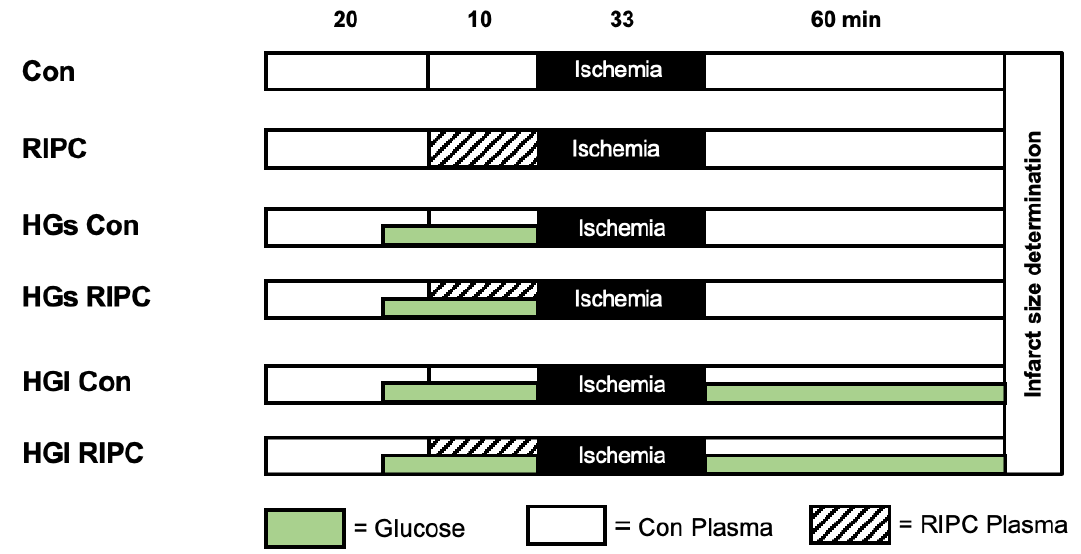
Figure 3. Experimental protocol (Part 2). Con = control plasma; RIPC = RIPC plasma; HG = hyperglycemia; HGs = hyperglycemia short; HGl = hyperglycemia long; Green bar = hearts were perfused with a total of 22 mmol/L glucose concentration. Control ( Con ) : hearts were perfused with control plasma for 10 min prior ischemia under normoglycemia, short ( HGs Con ), or long ( HGl Con ) hyperglycemia, respectively. RIPC: hearts were perfused with RIPC plasma for 10 min prior ischemia under normoglycemia, short ( HGs RIPC ), or long ( HGl RIPC ) hyperglycemia respectively. All hearts underwent 20 min of equilibration period, 10 min of preconditioning period, 33 min of ischemia, followed by 60 min of reperfusion. Global ischemia was induced by complete suppression of retrograde perfusion via the Langendorff Apparatus. At the end of ischemia, perfusion was restored to initiate the reperfusion period. Prior to ischemia, hearts were perfused for 10 min as a preconditioning intervention with either control (Con) or RIPC (RIPC) plasma from volunteers. Preconditioning with human RIPC plasma was achieved by administrating undiluted plasma via a syringe pump (Perfusor Space, B.Braun, Melsungen, Germany) at an infusion rate of 1% of the coronary flow. Plasma was not dissolved but applied